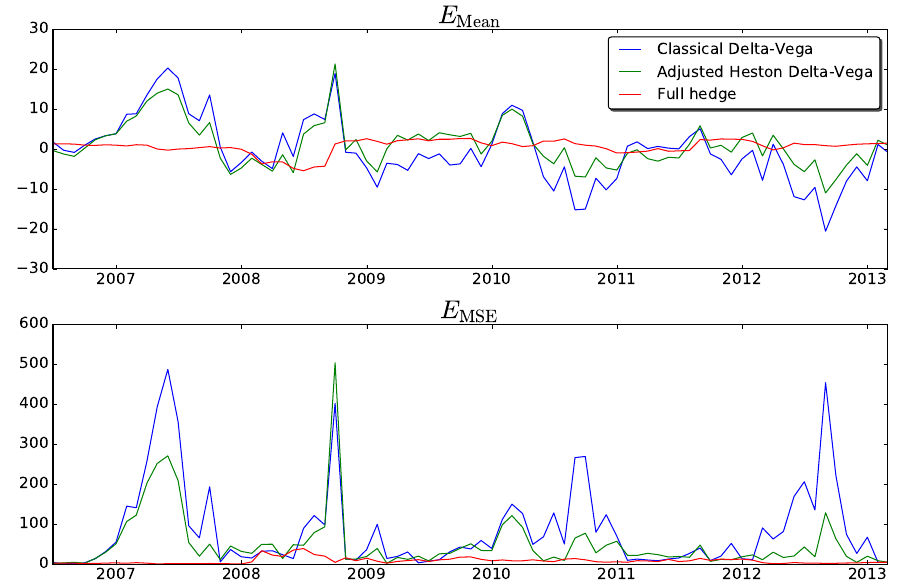
Figure 2. Mean error and mean squared error for different hedging strategies performed on monthly historical